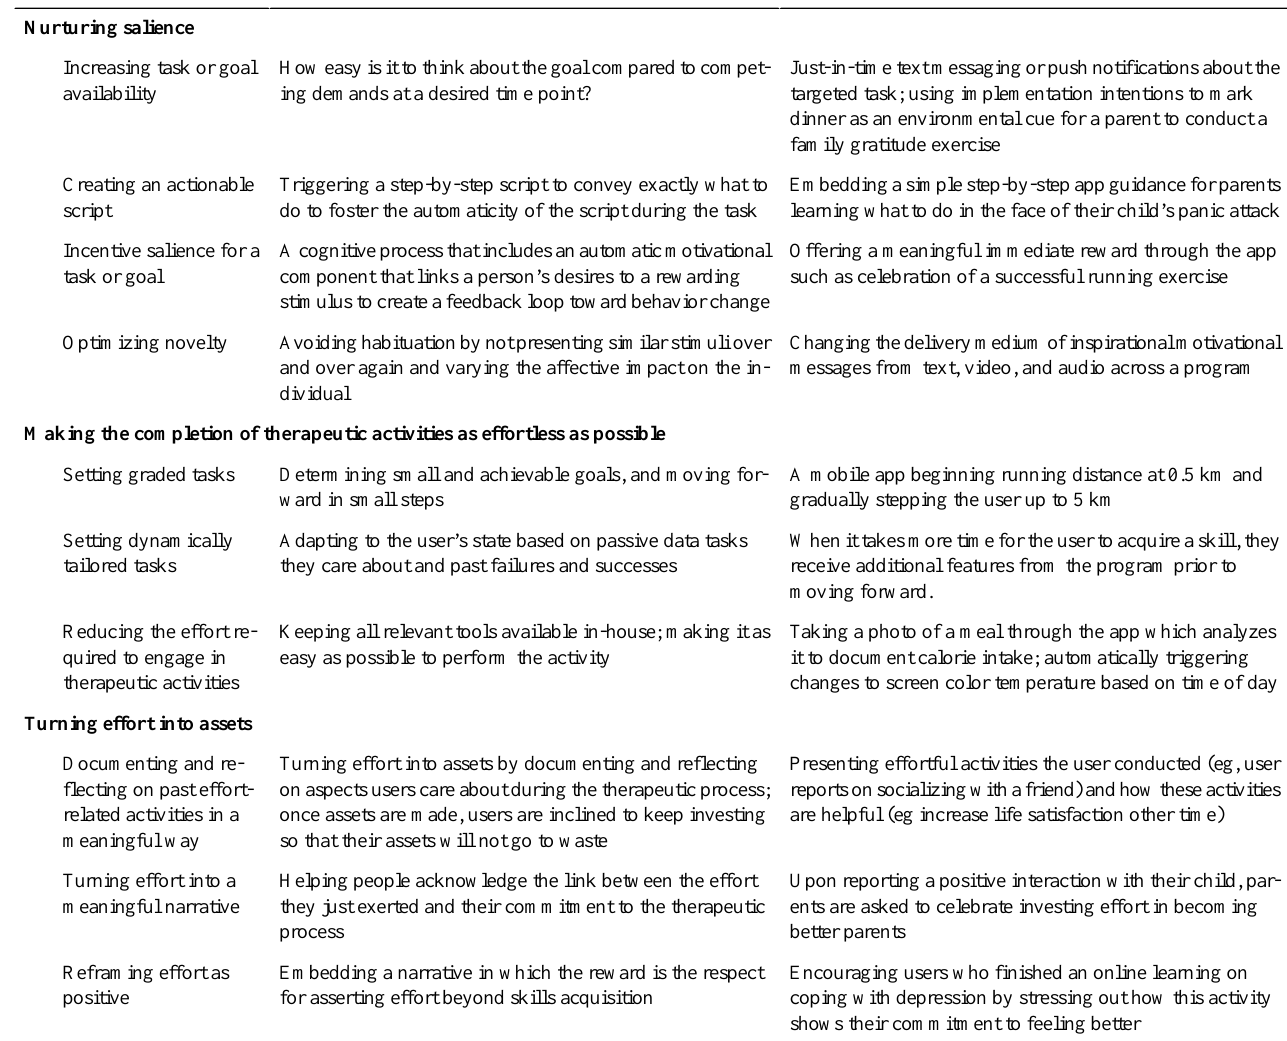
Table 1. Summary of the effort-optimized intervention 3-step design process and related components.